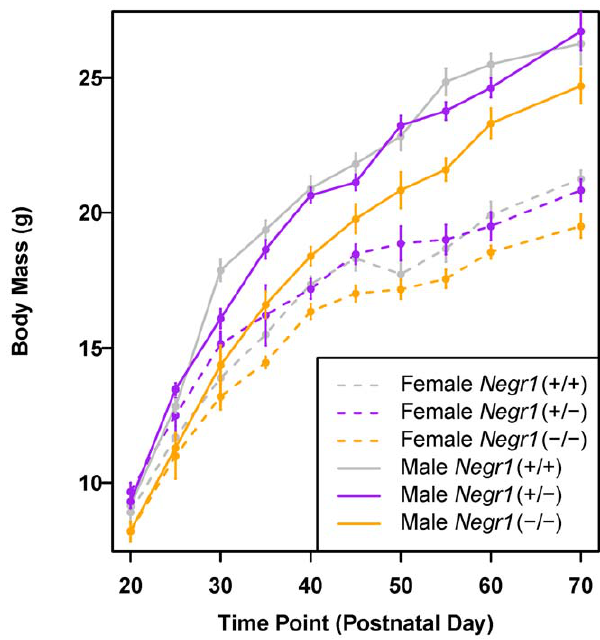
Figure 2. Mice deficient of NEGR1 exhibit reduced body mass and lean mass. Growth curve of Negr1 -KO females ( Negr1 + / + , n , 13; Negr1 + / 2 , n , 7; Negr1 2 / 2 , n , 10), and males ( Negr1 + / + , n , 17; Negr1 + / 2 , n , 21; Negr1 2 / 2 , n , 15) on standard chow diet measured across 10 weeks. Data shown are mean + / 2 SEM within each sex-genotype group at each time point. doi:10.1371/journal.pone.0041537.g002 points and correcting for multiple testing this was significant at all except the first time point in males (Table S1). Total gram fat mass was not affected in Negr1 -I87N mice (Fig. 3C, Table 2 and Table S1).